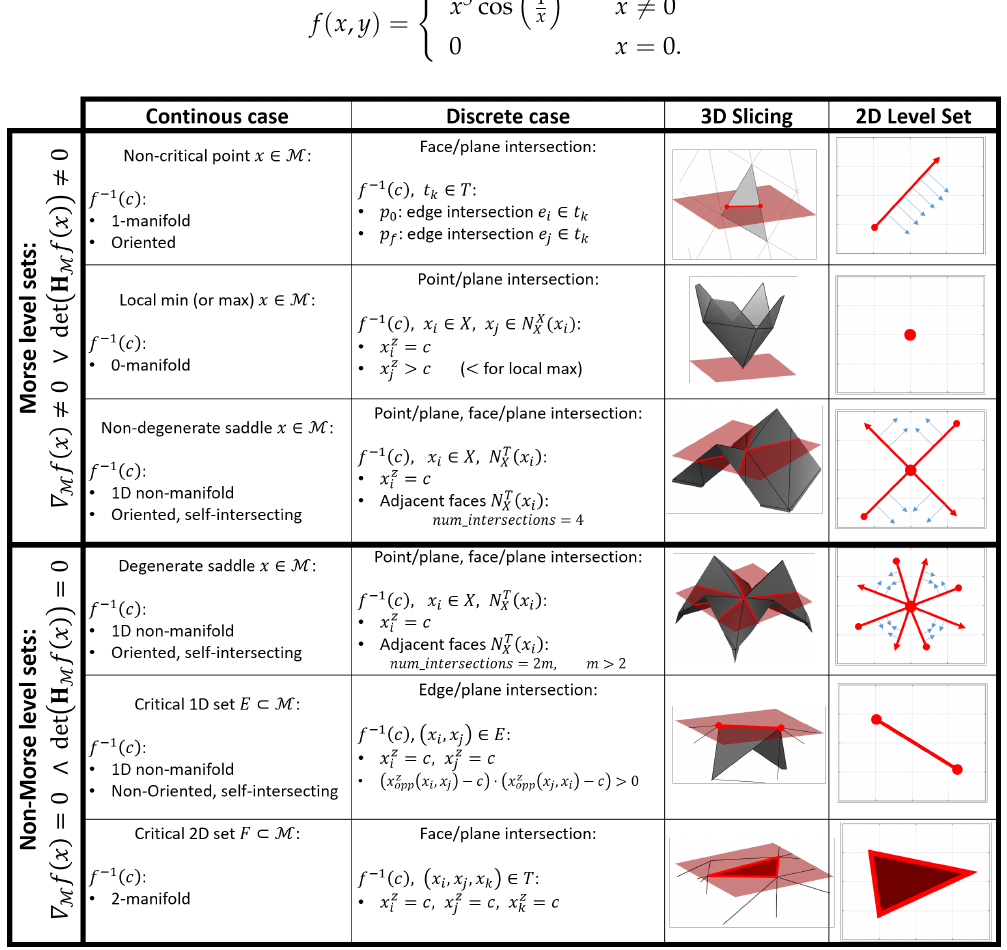
Figure 2. Type of level sets f − 1 for a weak-Morse function f . Level sets computed on a discrete 2-manifold M = ( X , T )